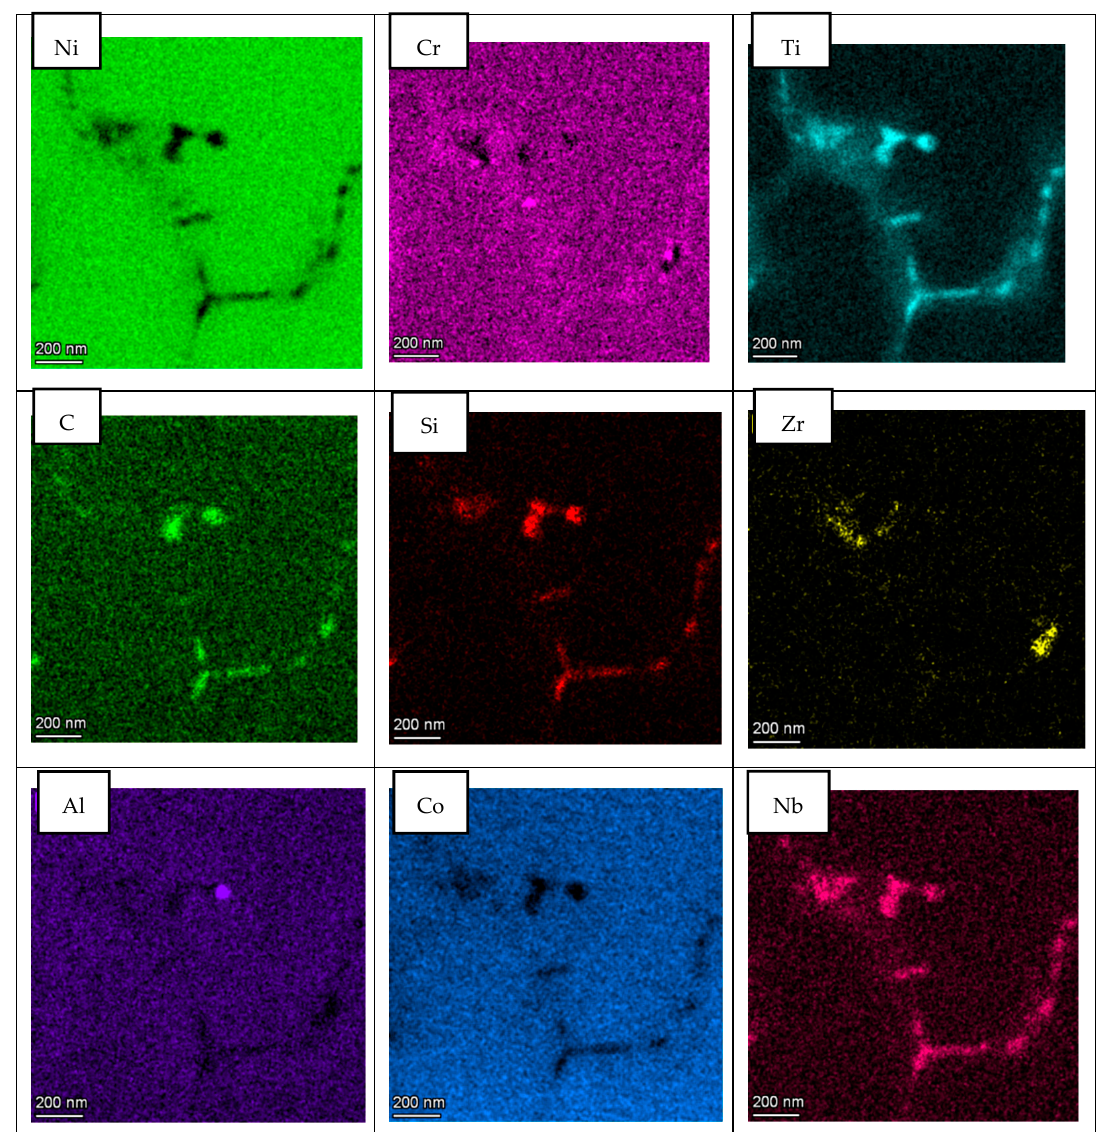
Figure 8. STEM EDS compositional maps of the LPW sample cell boundary.